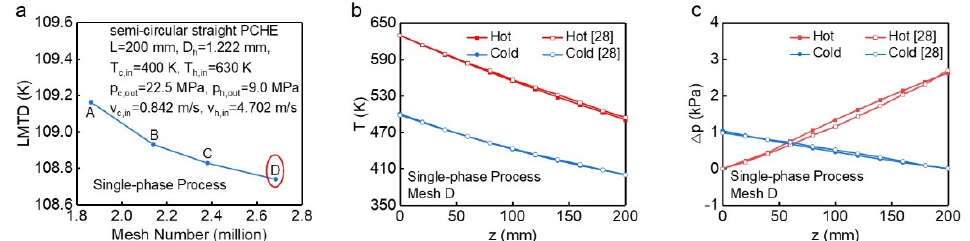
Figure 4. Validation of coupling trans-critical heat transfer process. ( a ) Mesh independence test. ( b ) Bulk temperature and ( c ) Pressure drop of current model and reference.